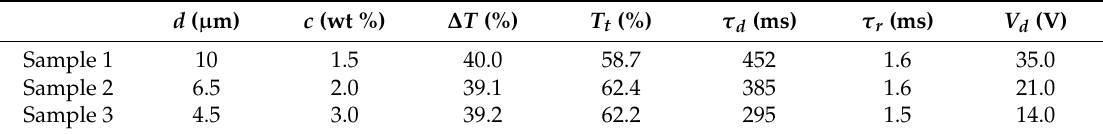
Table 2. The measured transmittance difference ∆ T , transmittance in the transparent state T t , decay time τ d , rise time τ r , and driving voltage V d of the fabricated ChLC cells. d ( µ m) c (wt